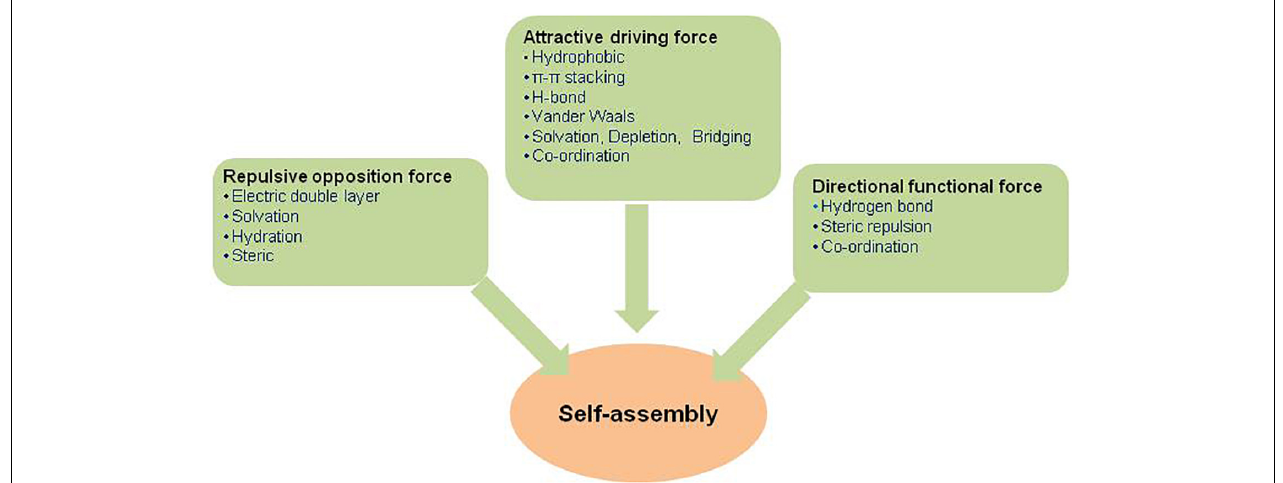
FIGURE 3 | Three classes of distinctive forces involved in